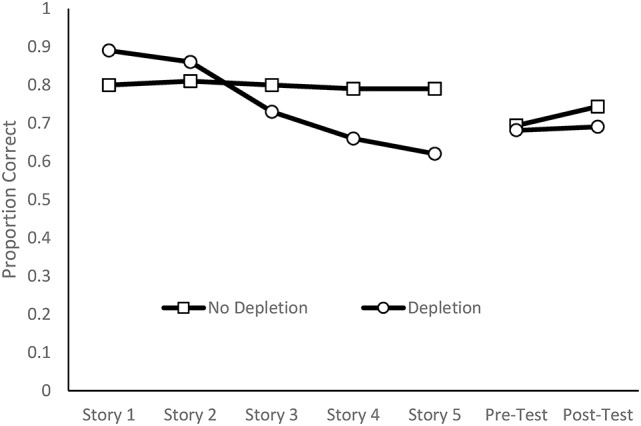
Proportion of targets detected and words remembered as a function of depletion group.